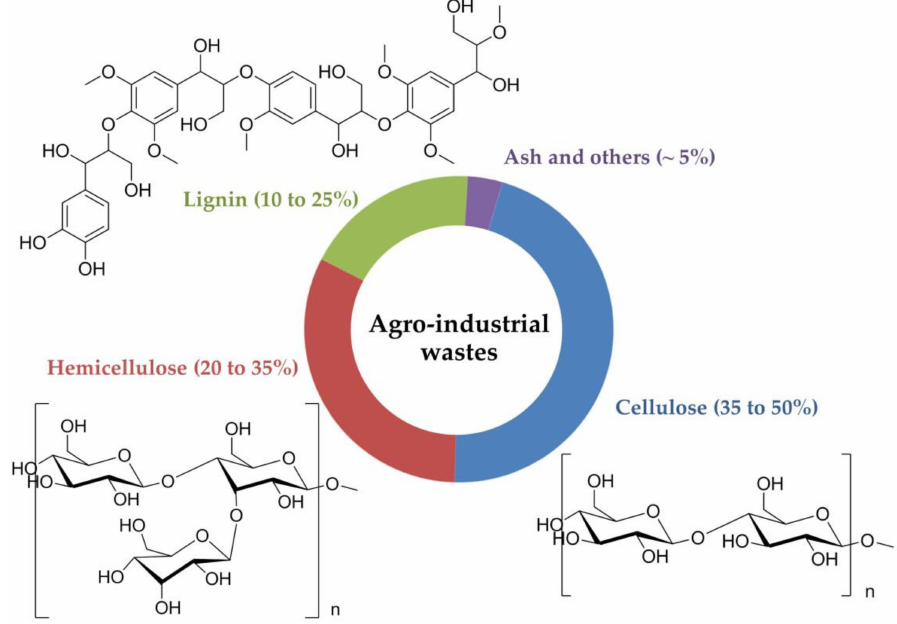
Figure 1. Main composition of agro-industrial